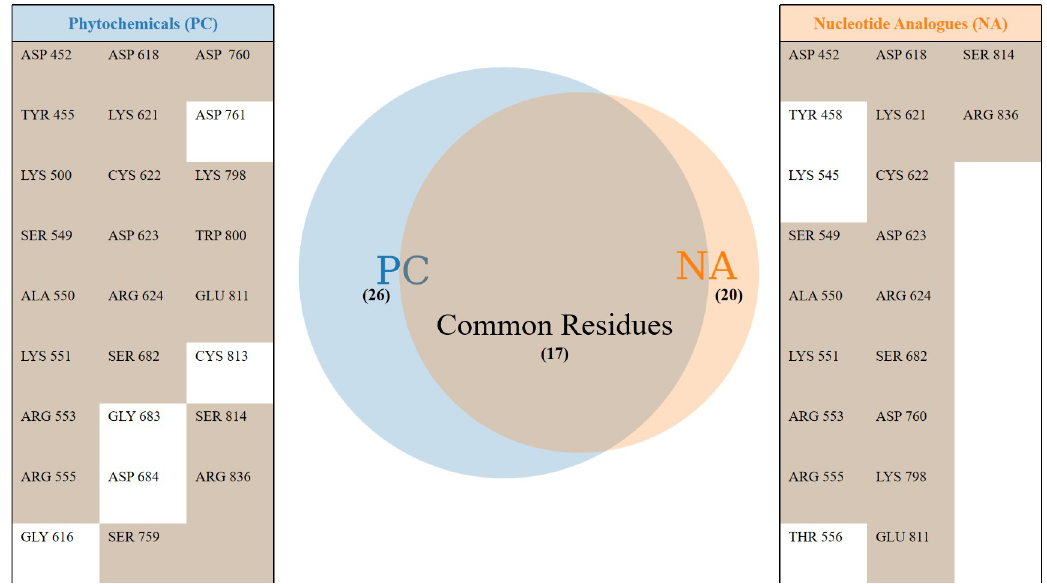
Fig 7. Inhibitor binding RdRP residues. Unique and common RdRP residues interacting with phytochemicals (PC) and nucleotide analogues (NA) observed through MD simulations.